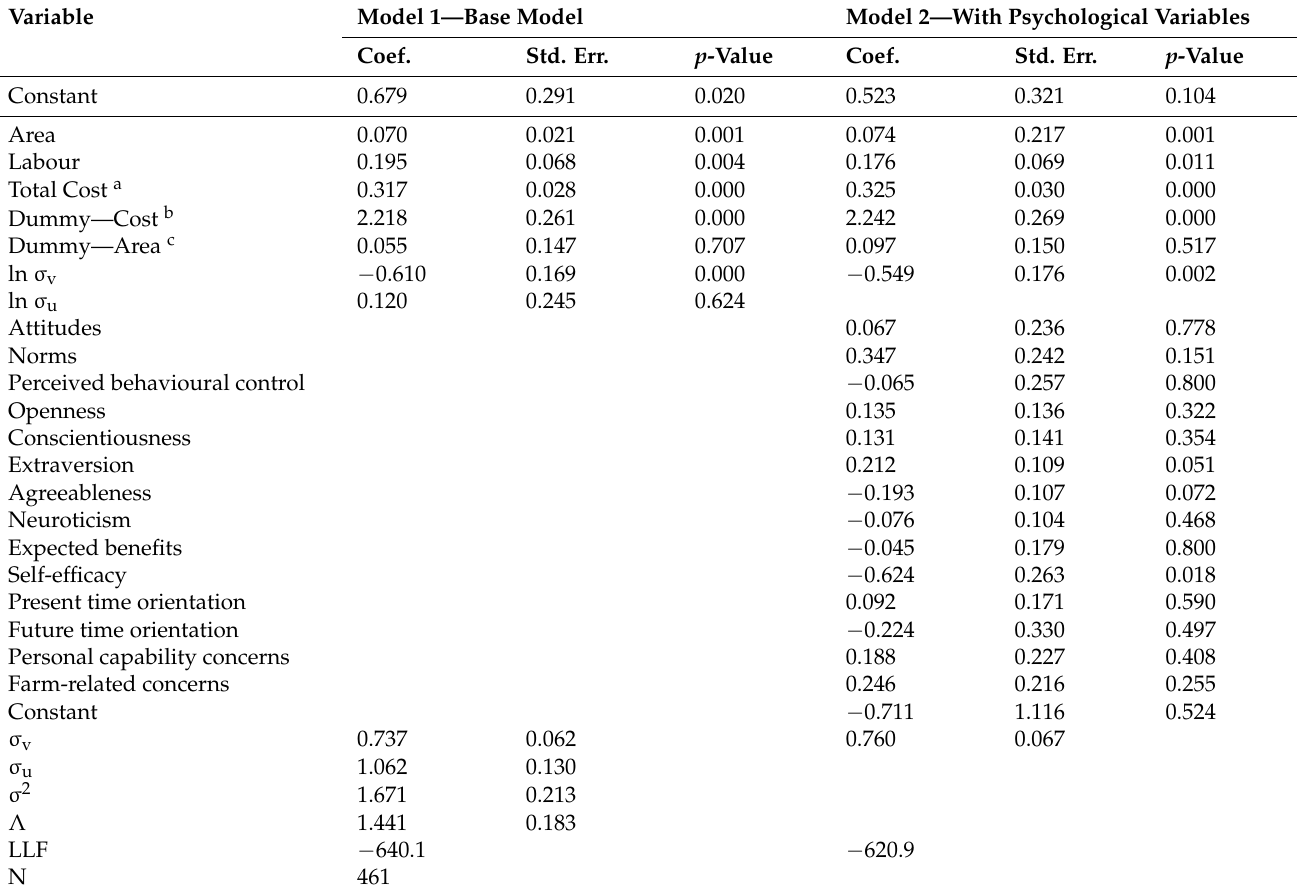
Table 8. Maximum-likelihood estimates of the Cobb–Douglas